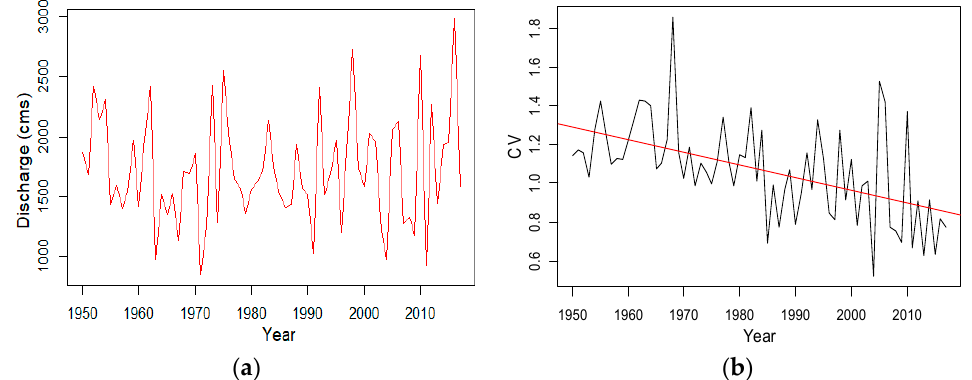
Figure 2. Mean annual discharge ( a ) and annual coefficient of variation (CV) of daily discharge ( b ) observed at Zhuqi during 1950–2017.